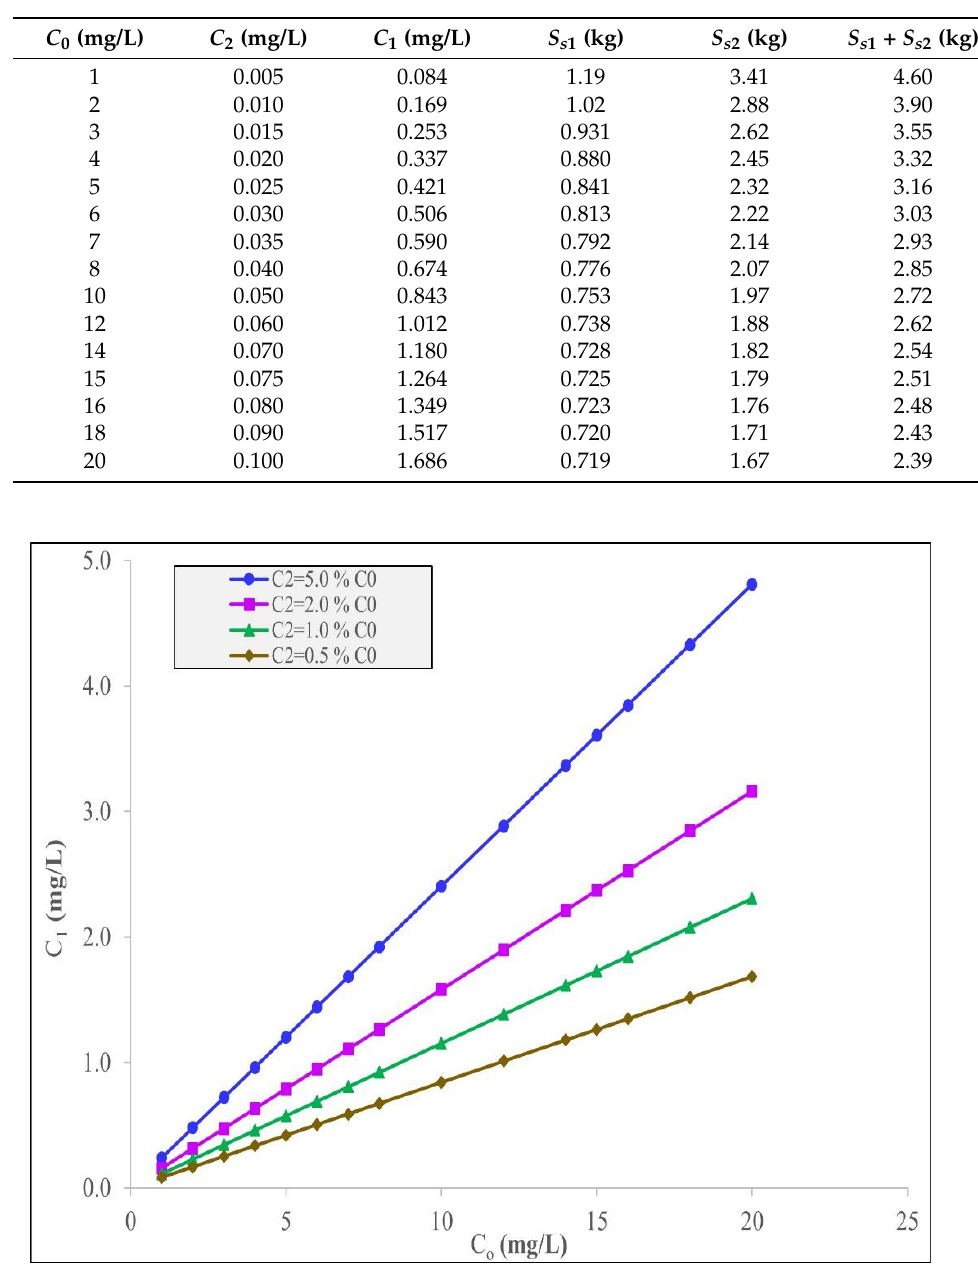
Table 5. Minimum total quantity of phosphoric-acid-treated date stone activated carbon to remove IBU using the Langmuir – Freundlich model to achieve C 2 = 0.5% C 0 for 1000 L of solution.